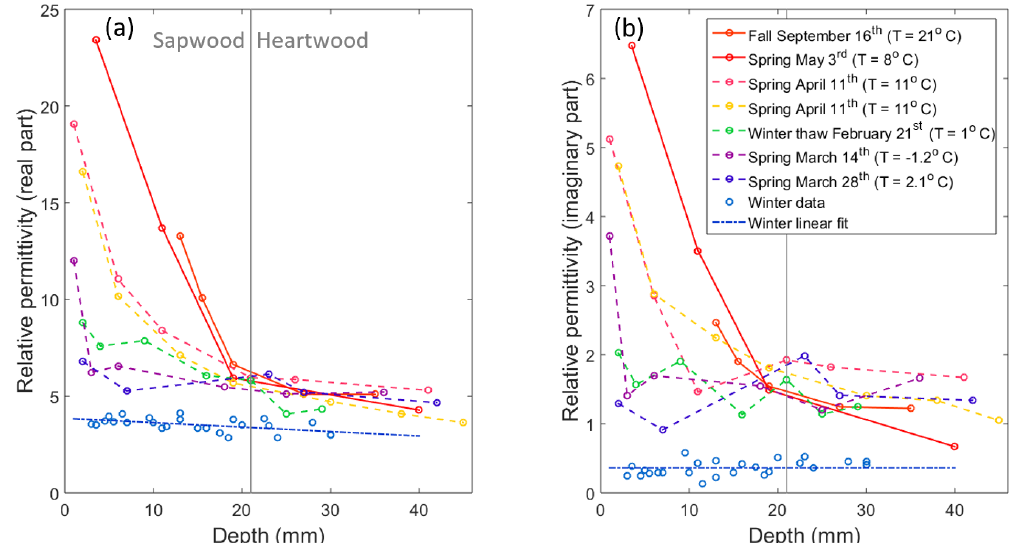
Figure 7. Trunk radial profile of the real (a) and imaginary (b) relative permittivity (unitless) at L band of black spruce at the OBS site in Saskatchewan. The gray vertical line approximates the sapwood depth estimated visually with tree core samples. The winter data were always collected well below the freezing point through the middle of